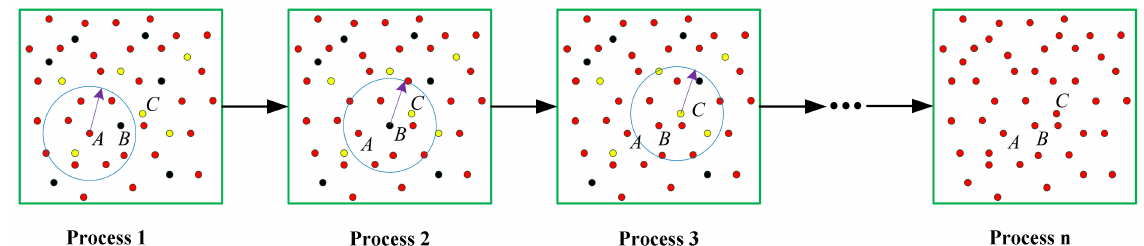
Figure 3. The classification results were corrected by K nearest neighbor (KNN). Each of these categories is represented by a different color. The radius is set as the starting point A , and a circle is drawn, as shown in Process 1. The categories within the statistical circle have the most dots in red. Therefore, the category A stays the same. In Process 2, it is found that the circle centered on B has more red dots; therefore, B is updated to red. In Process 3, C is updated to redpoint in the same manner. When each point is updated, points in the same plane are updated to the same class, as shown in Process